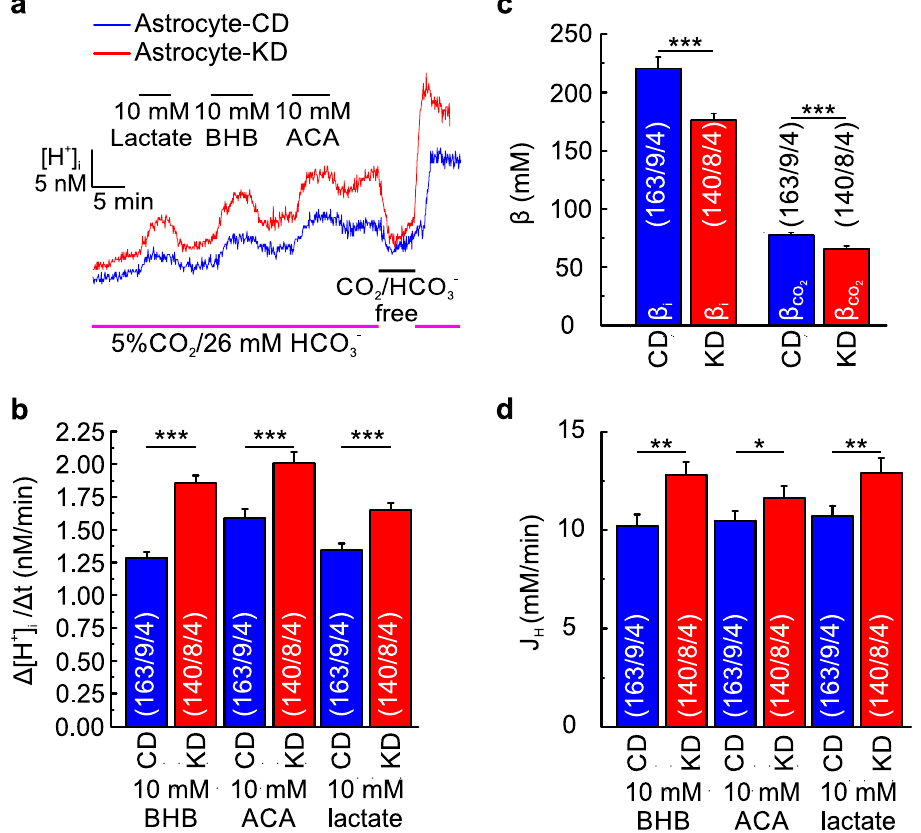
Figure 3. Ketogenic diet increases MCT transport activity in cortical astrocytes. ( a ) Original recordings of the change in [H + ] i , as induced by application of 10 mM lactate, BHB and ACA in cortical astrocytes from mice fed with control diet (CD, blue traces) and ketogenic diet (KD, red traces) in 5% CO 2 /26 mM HCO 3 − -buffer, then a pulse of CO 2 /HCO 3 − -free buffer was given. ( b ) ∆ ∆ + [H ] / t , as induced by application of 10 mM of BHB, ACA i and lactate in CO 2 /HCO 3 − -buffer in cortical astrocytes from CD (blue bars) and KD (red bars). ( c ) Intrinsic ( β i ) and CO 2 /HCO 3 − -dependent β ( ) buffer capacity in cortical astrocytes from CD (blue bars) and KD (red bars). CO 2 ( d ) J H , as induced by 10 mM of BHB, ACA and lactate in CO 2 /HCO 3 − -buffered solution in astrocytes from CD (blue bars) and KD (red bars). Statistical values are presented as means ± S.E.M. Significance was tested with a paired Student’s t-test. Number of astrocytes/slices/mice are indicated in the bar